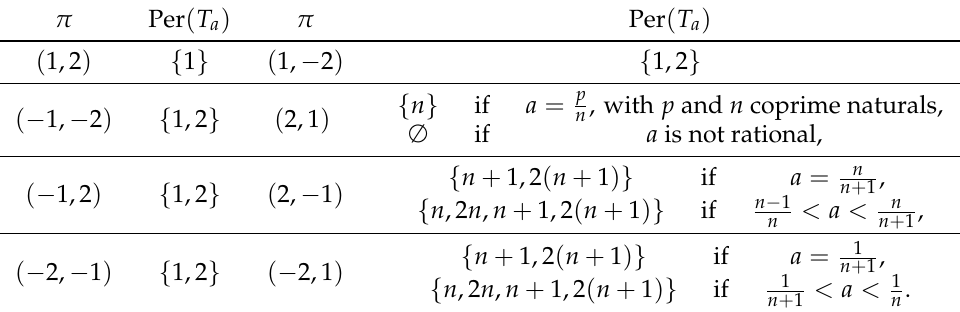
Table 1. For 0 < a < 1, n ∈ N , and the 2-IET T a with discontinuity at a , it is summarized the set of periods according to the permutation π .